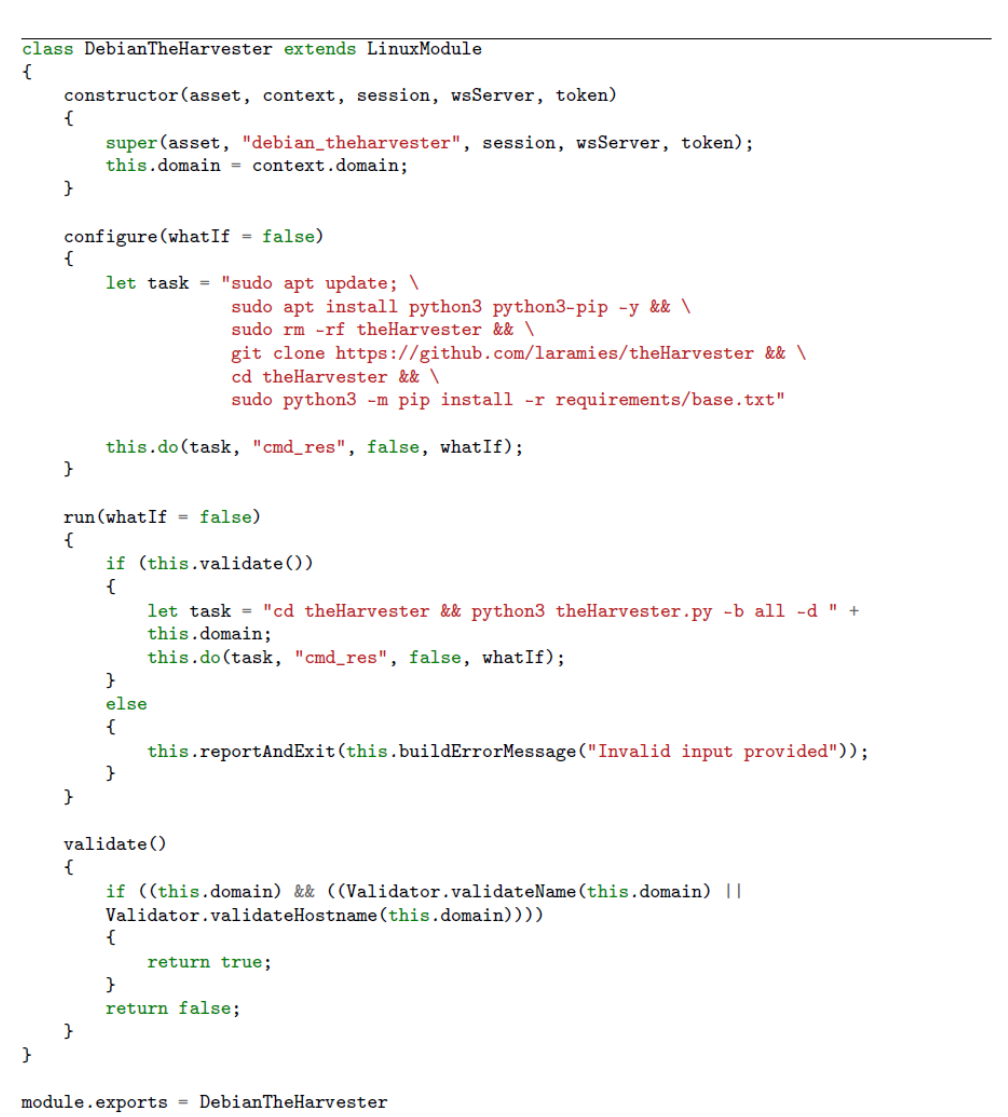
Figure 7. Example of module